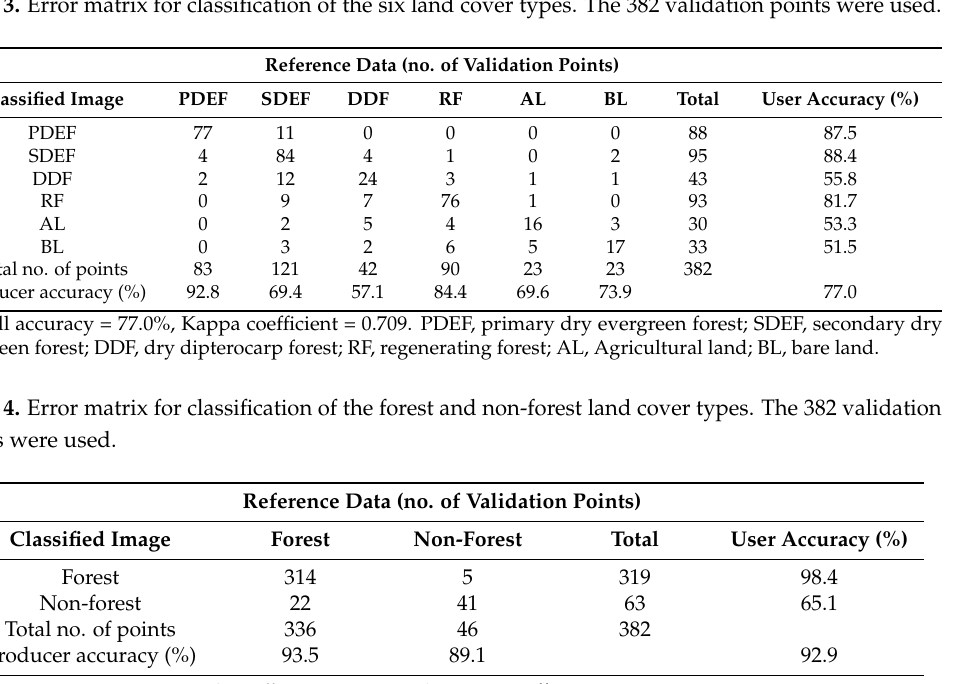
Table 3. Error matrix for classification of the six land cover types. The 382 validation points were used.